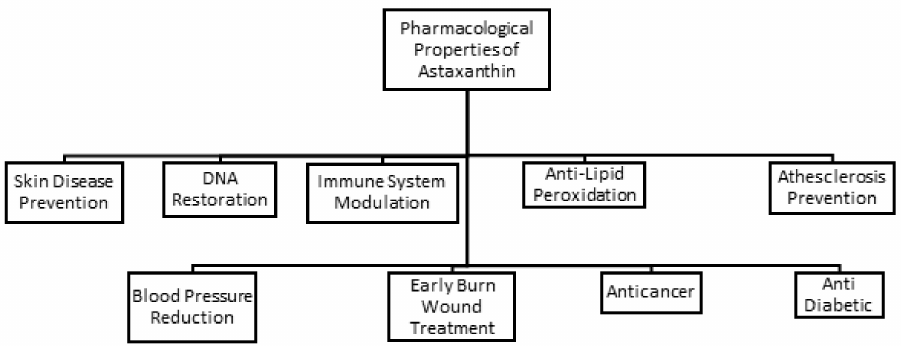
Figure 2. Various pharmacological properties of